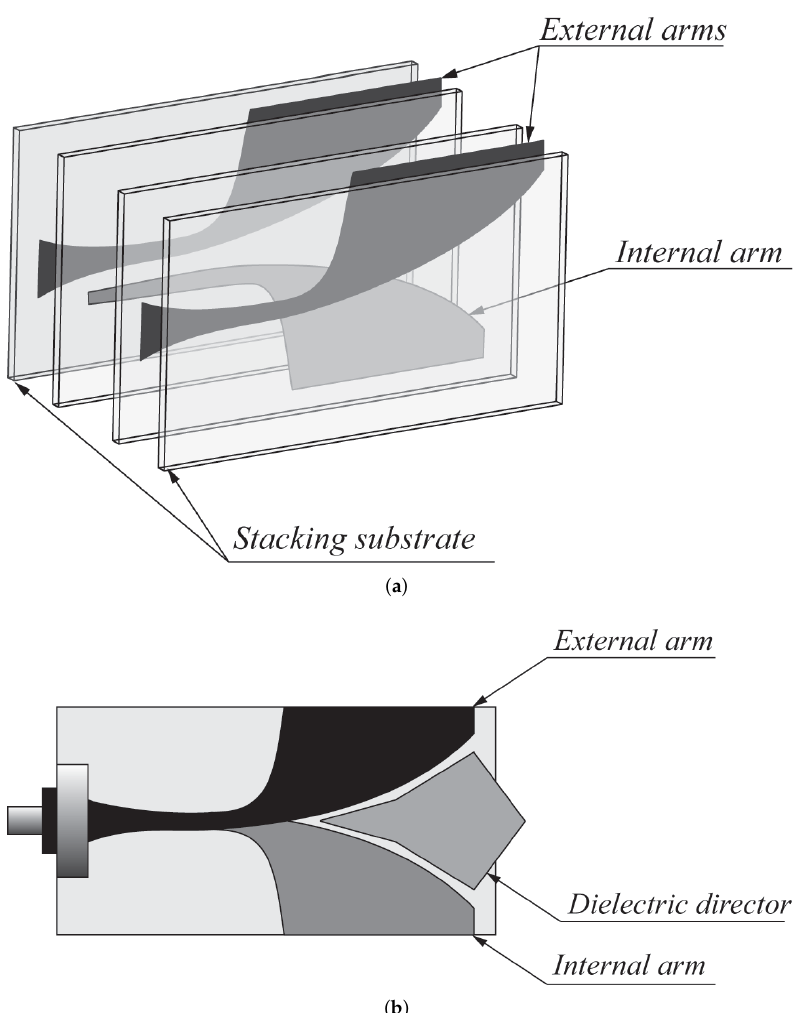
Figure 6. ( a ) Multi-layer BAVA design (redrawn from [36]) ( b ) BAVA with dielectric reflector (redrawn from [49,50]). Black external arm, dark gray internal arm, medium gray dielectric director, and light gray dielectric